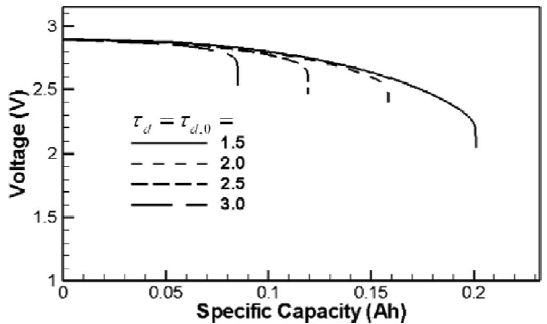
Figure 13. Li-air battery performance under varying electrode tortuosity. Republished from Wang and Cho [22] with permission of The Electrochemical Society, conveyed through Copyright Clearance Center, Inc.